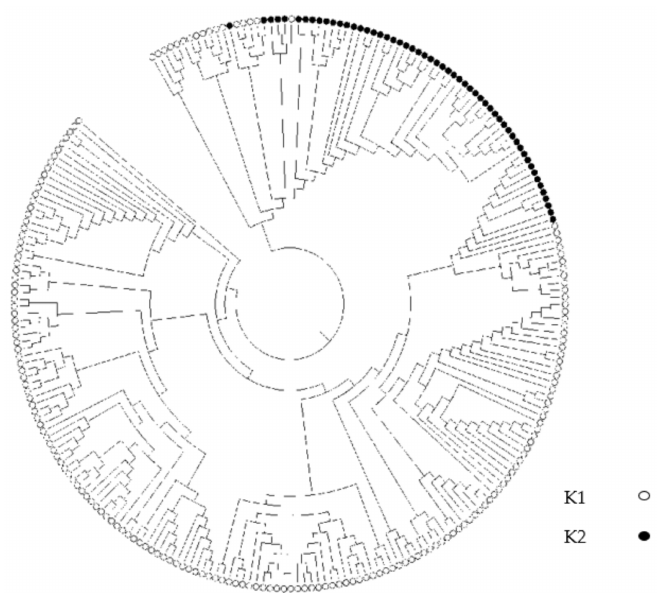
Figure 4. A neighbor-joining tree of G. soja .